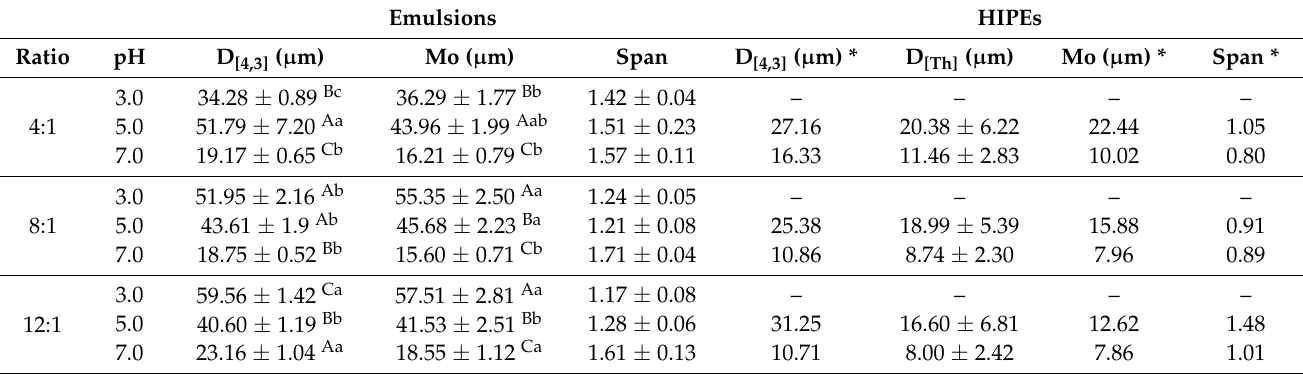
Figure 3. Micrographs and droplet size distribution of emulsions produced at pea protein: xanthan gum (PP:XG) ratio of 4:1, 8:1, and 12:1; and pH 3, 5, and 7. Bar scale: 10 µm. Table 2. Droplet mean diameter (D [4,3] , D [Th] ), mode (Mo) and Span of the emulsions and